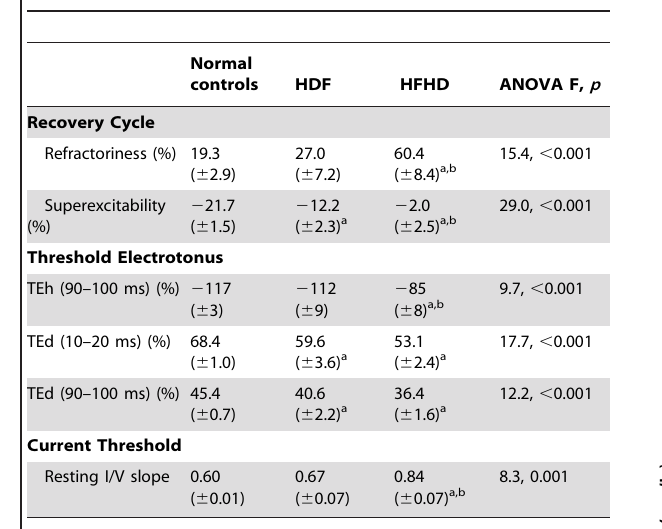
Table 2. Pre-RRT nerve excitability results for HDF and HFHD groups compared to controls.